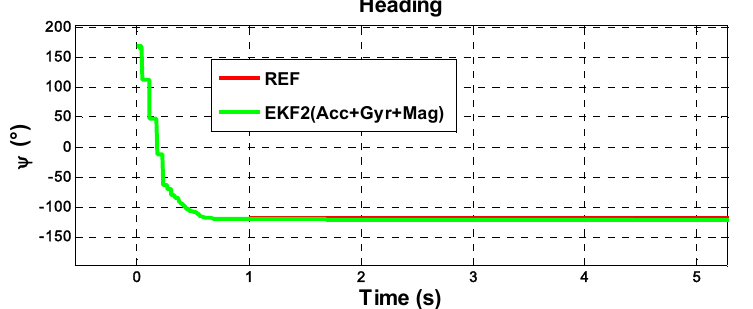
Figure 7. The initial transients of heading estimates in EKF2.